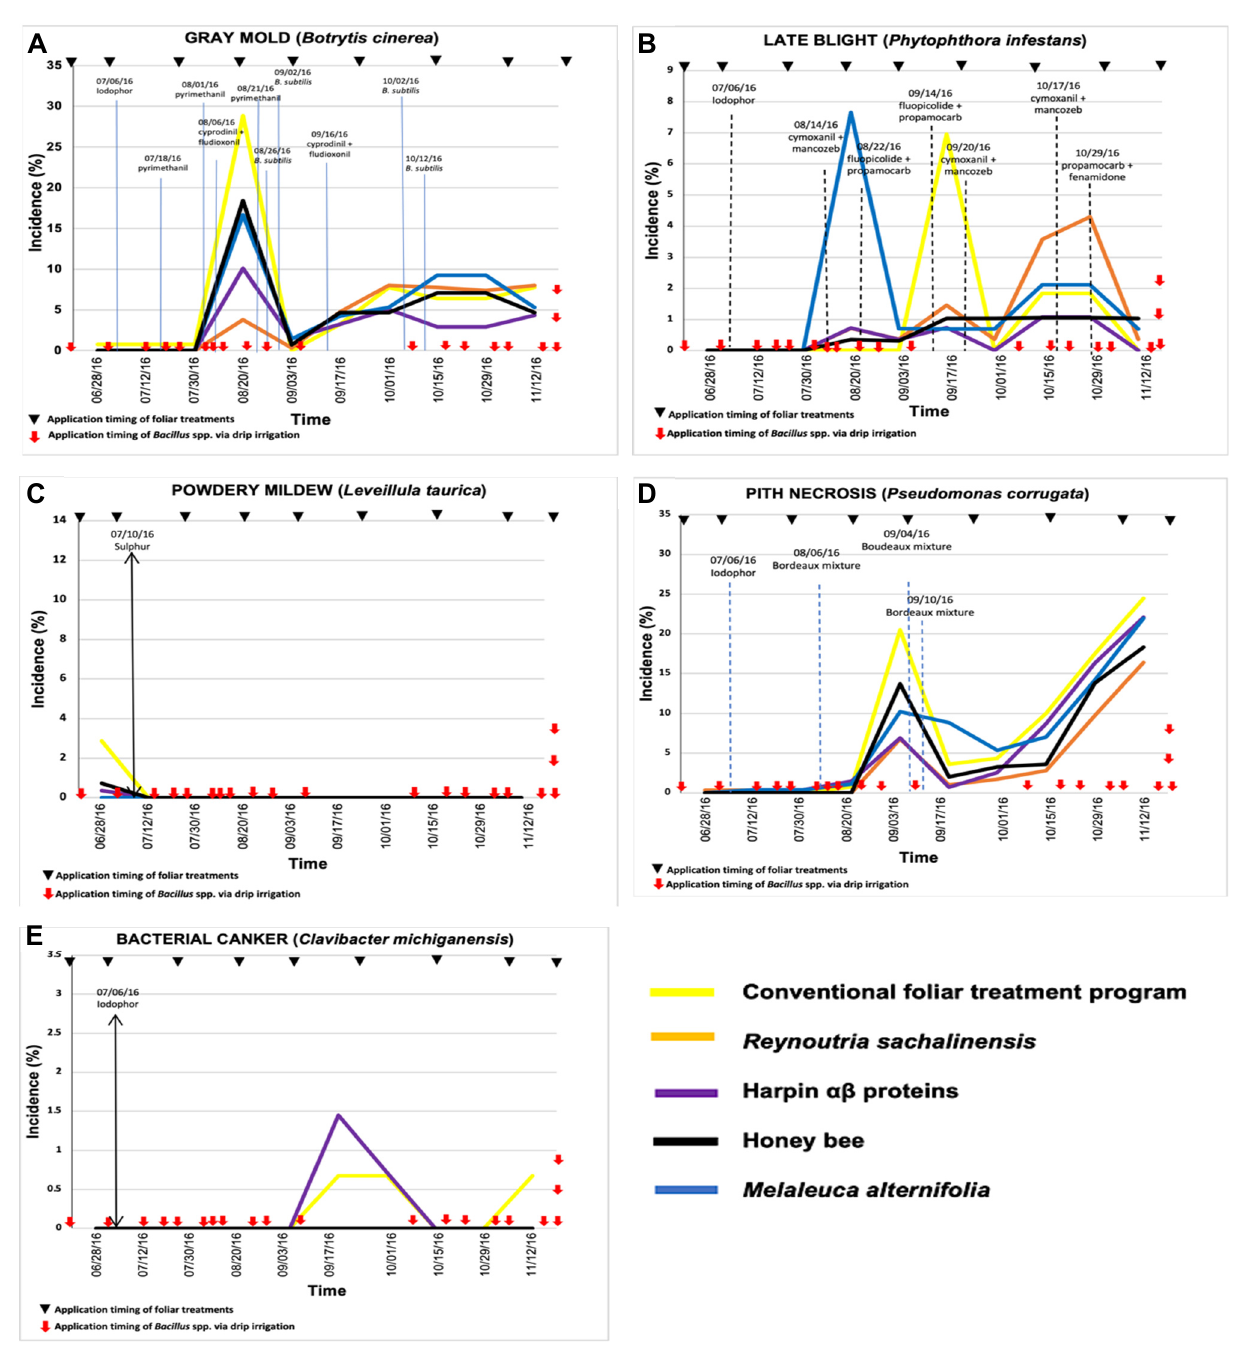
Figure 1. Temporal progress of five major tomato diseases—( A ) gray mold ( Botrytis cinerea ), ( B ) late blight ( Phytophthora infestans ), ( C ) powdery mildew ( Leveillula taurica ), ( D ) pith necrosis ( Pseudomonas corrugata ), and ( E ) bacterial canker ( Clavibacter michiganensis )—under the effect of different treatments consisting of soil application of Bacillus spp. via drip irrigation and foliar application of biorational products via spraying in greenhouse tomato production in Mexico in 2016. Dotted vertical lines in graphs indicate the approximate timing of application of fungicides in the conventional management program or in any other treatment due to low intensity tolerance to disease. Incidence values are the average of three replications.